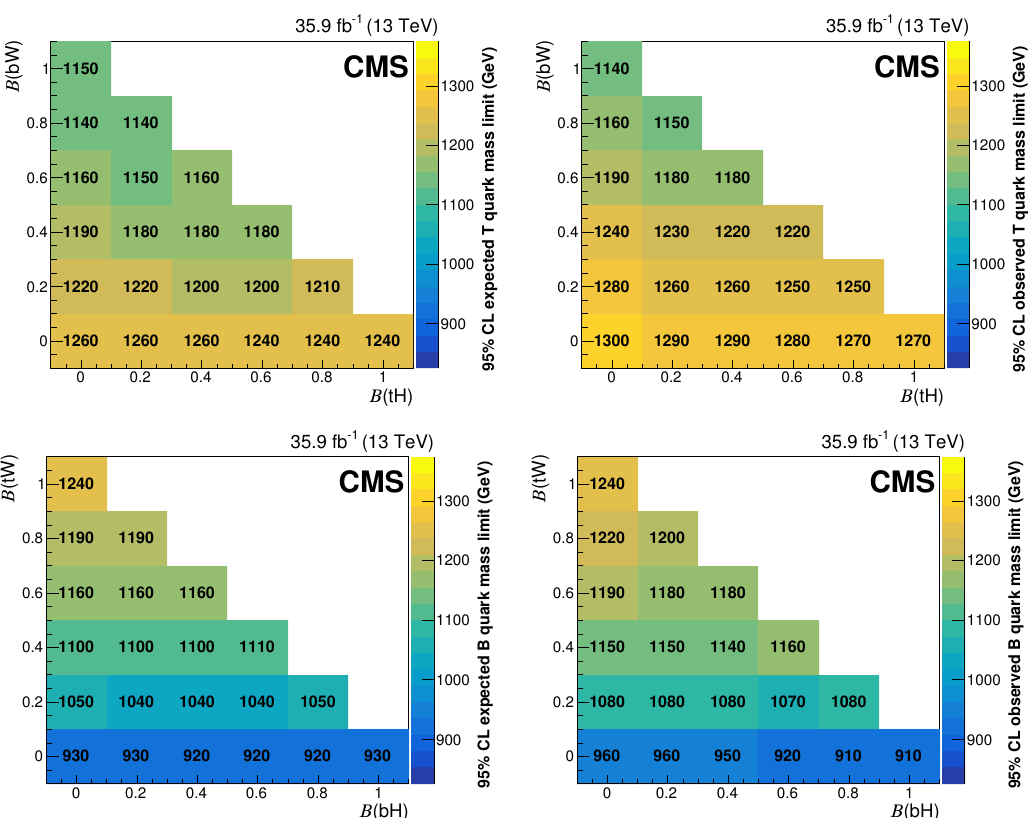
Figure 9 . The 95% CL expected (left) and observed (right) lower limits on the T quark (upper row) and B quark (lower row) mass, expressed in GeV, after combining all channels for various branching fraction